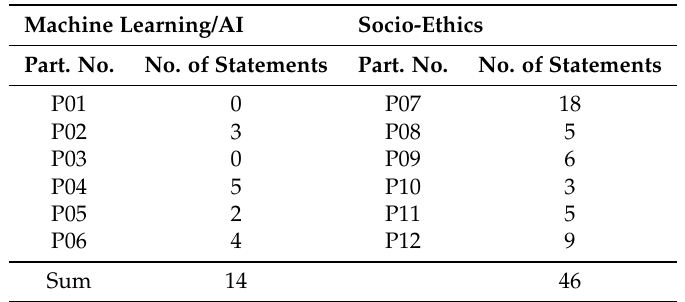
Table 2. Number of statements per interviewee related to being transparent. Machine